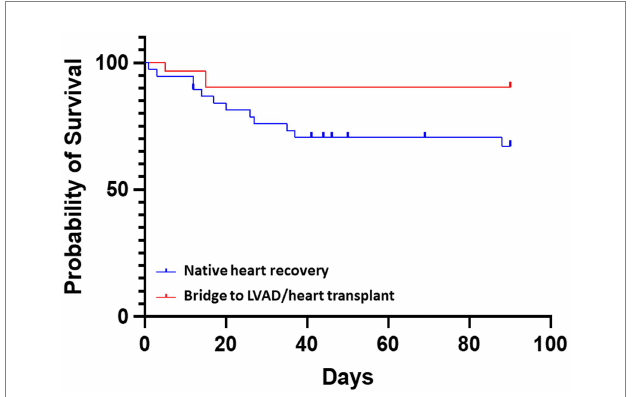
FIGURE 2 Comparative survival for patients receiving Impella 5.5. The probability of survival was greater in patients with a bridge to LVAD/heart transplant vs. bridge to native heart recovery (non LVAD/heart